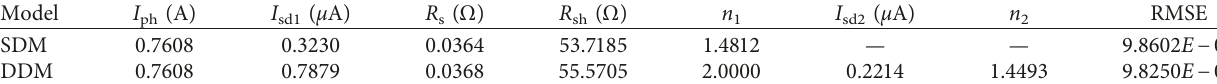
Table 4: Extracted value for the parameters of the RTC France solar cell by